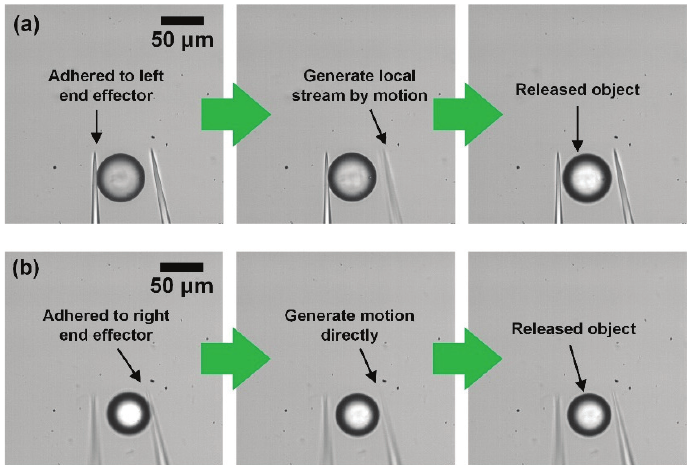
Figure 6. Automatic releasing ( a ) When the object is adhered to left; ( b ) When the object is adhered to right.